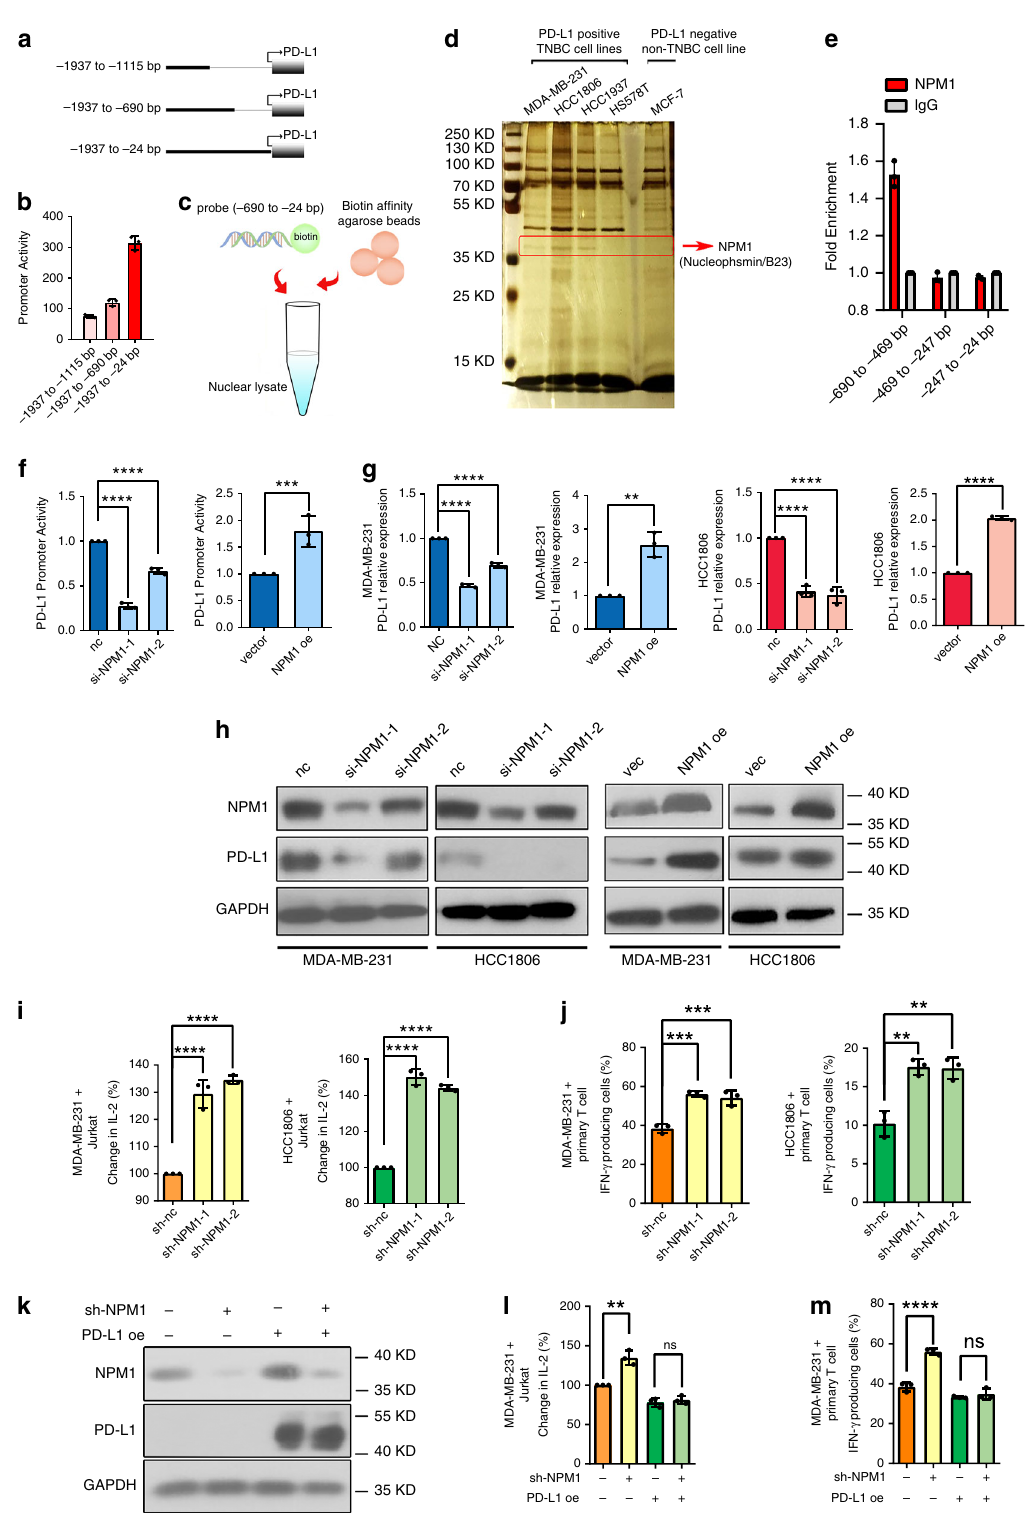
lines with NPM1 silenced by lentiviral short-hairpin RNA (shRNA) and downregulated PD-L1. As shown in Supplementary Fig. 1D, knockdown of NPM1 also decreased PD-L1 expression in the presence of IFN- γ , suggesting that NPM1 was a dominant regulatory factor for PD-L1 expression in TNBC cells. Flow cytometry demonstrated that knockdown of NPM1 caused decreased expression of PD-L1 on the surface of TNBC